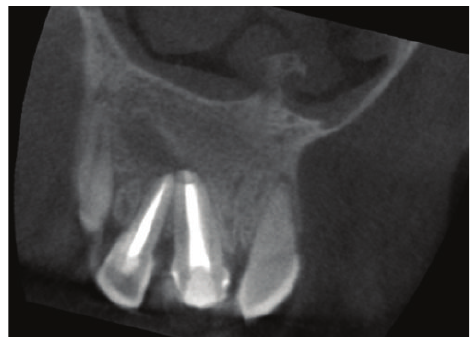
Figure 48: 1-year followup CBCT image in coronal plane.